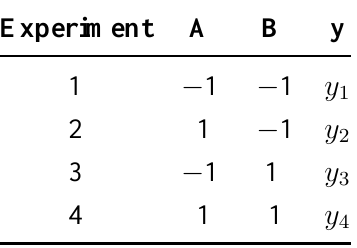
Table 1. Experiments defined by a 2 2 design.